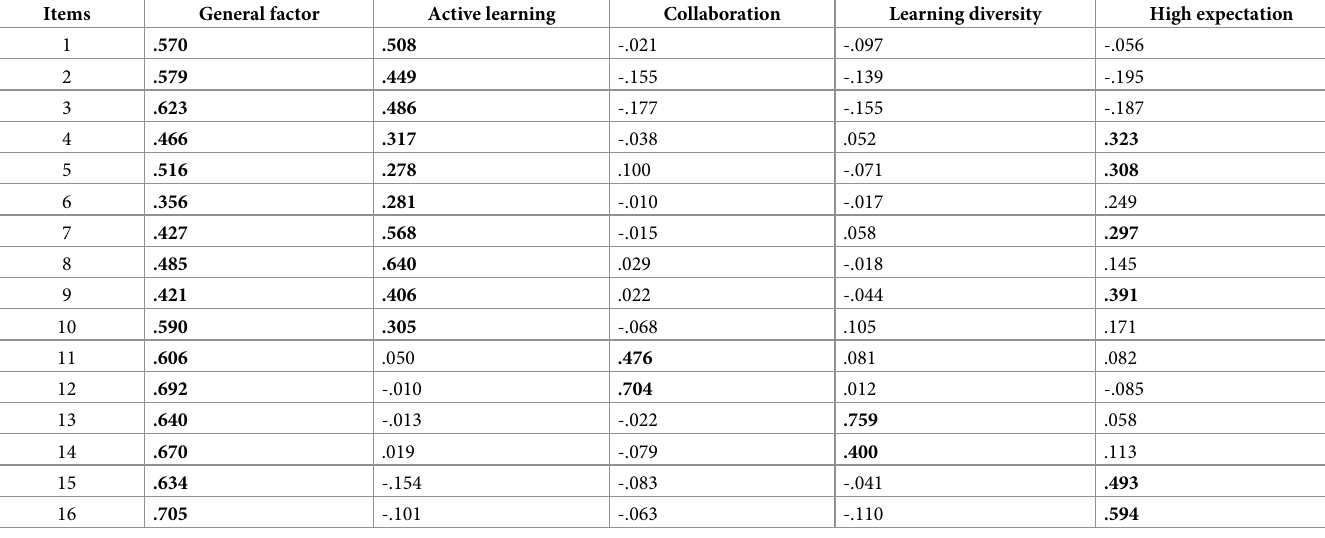
Table 6. Loading matrix related to the exploratory bifactor solution.